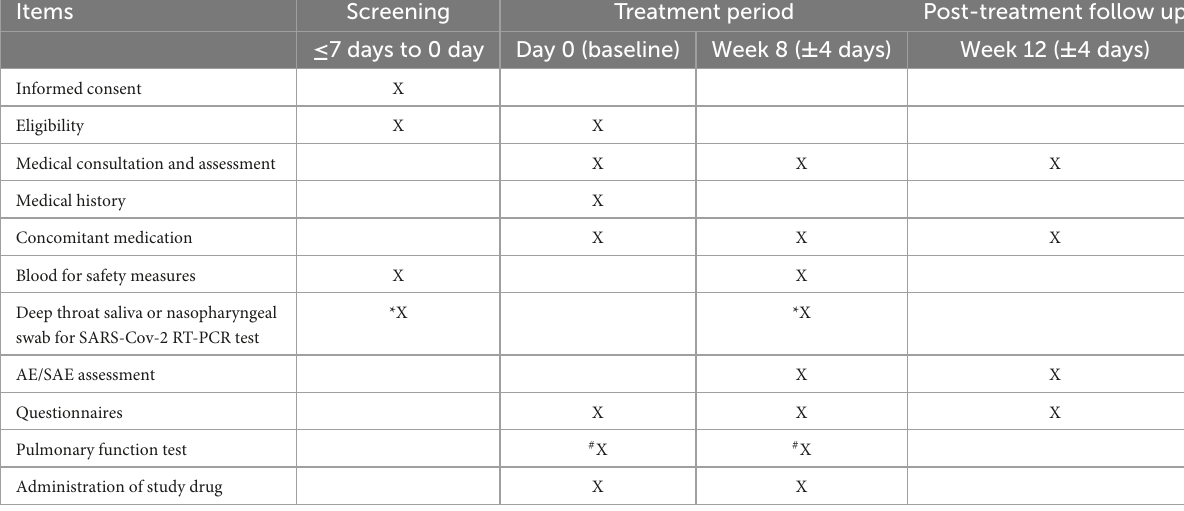
TABLE 1 Study schedule. Items